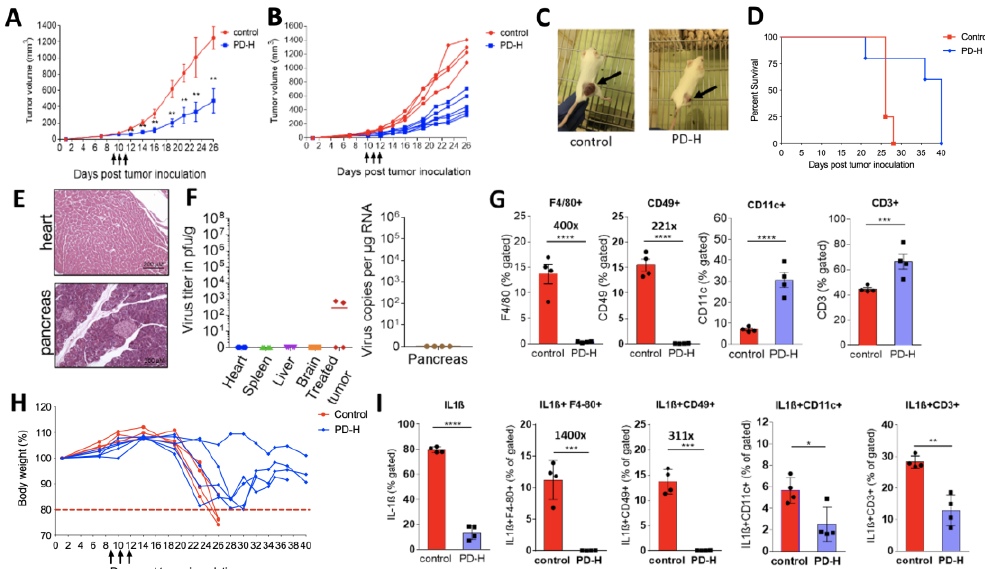
Figure 4. Oncolytic efficiency of PD-H in a Colon-26 tumor syngenic mouse model. Colon-26 cells were subcutaneously inoculated onto the right flank of BALB/c mice. When the tumor size reached ~0.5 cm diameter 3 × 10 6 pfu of PD-H ( n = 6) or PBS (control, n = 4) was injected i.t. Injection of 3 × 10 6 pfu PD-H or PBS by the same route was repeated after one and two days. ( A ) Tumor volumes are shown as means ± SEM for each group. Significance: ** p < 0.01. ( B ) Data of A shown for each animal. ( C ) Image of PD-H-treated Colon-26 tumor mice. PD-H treated mouse: black arrow shows PD-H injected tumor; control mouse: black arrow shows PBS-injected tumor. Images were taken on day 20 after tumor cell injection. ( D )